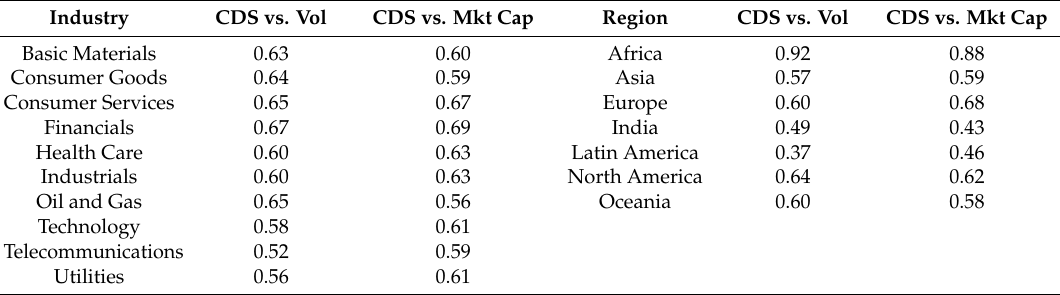
Table 3. Correlation of CDS vs. implied volatility and CDS vs. market capitalization 1